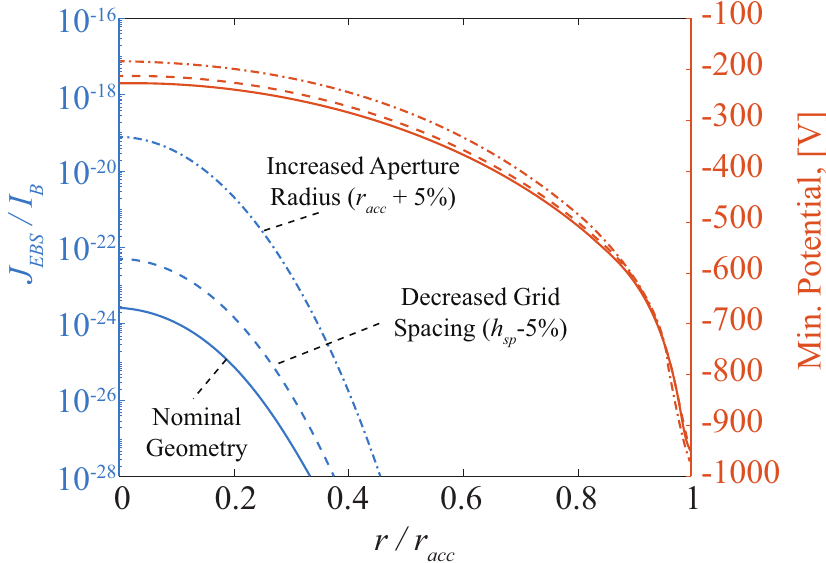
Figure 11. Radial profiles of backstreaming current density and minimum potential for varying geometries. The majority of flux occurs through a small region near the centerline.